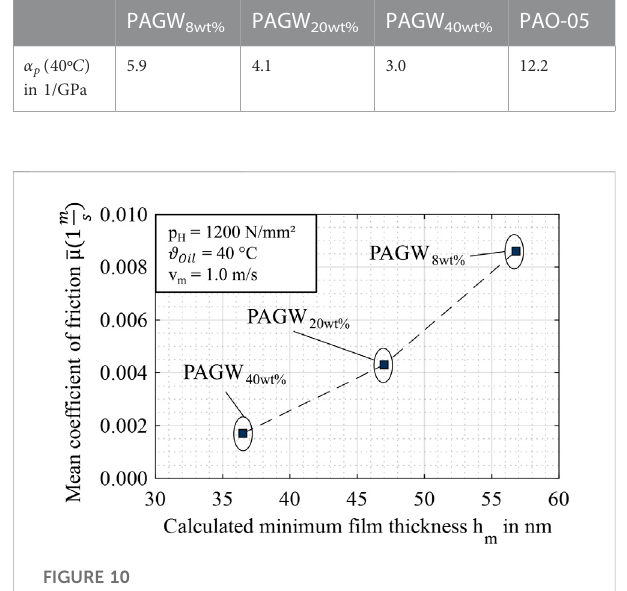
FIGURE 10 Mean coef fi cient of friction (cid:2) µ (1 m/s) over calculated minimum fi lm thickness h m at p H = 1200 N/mm 2 for the considered PAGWs.